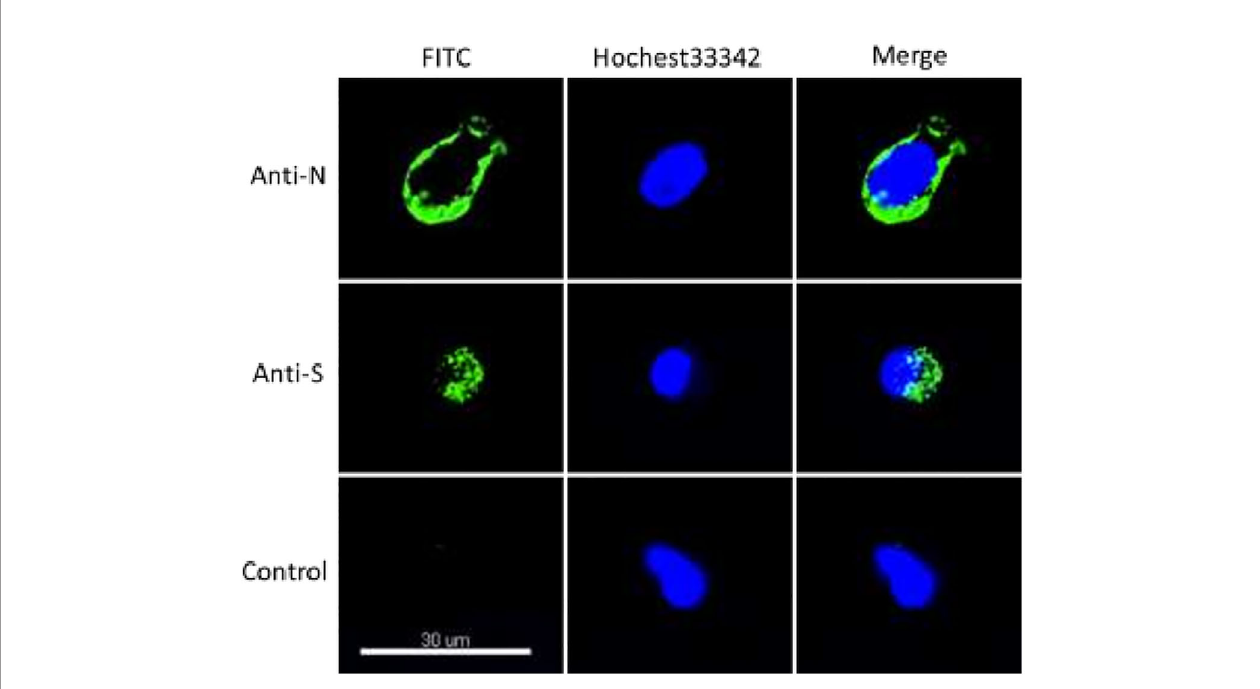
FIGURE 3 | SARS-CoV-2 was detected using immuno fl uorescence in the aqueous humor. Cells were fi xed and incubated with the antibodies of SARS-CoV-2 spike (S) protein, nucleocapsid (N), respectively. This picture shows SARS-CoV-2 was detected in the aqueous humor of the left